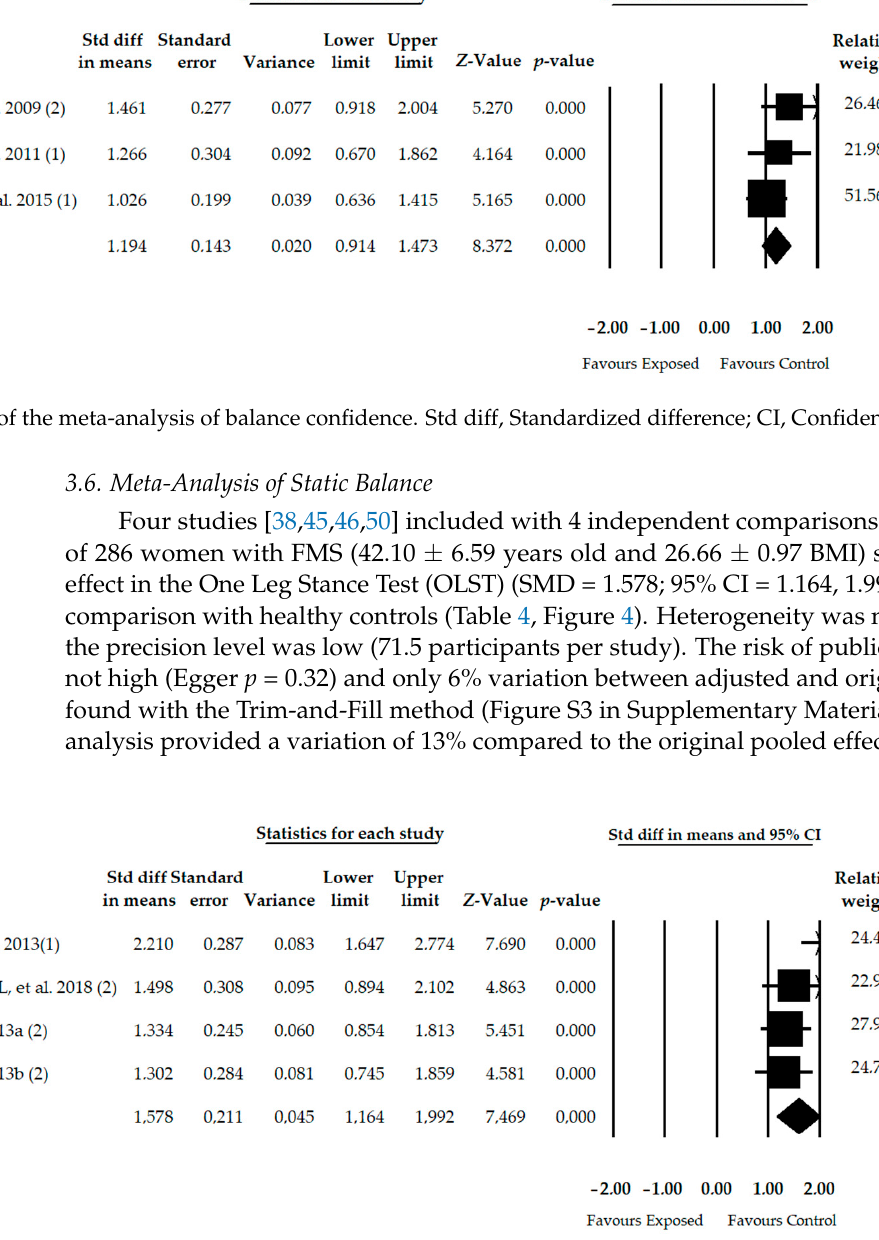
Figure 4. Forest plot of the meta-analysis of static balance. Std diff, Standardized difference; CI, Confidence interval.